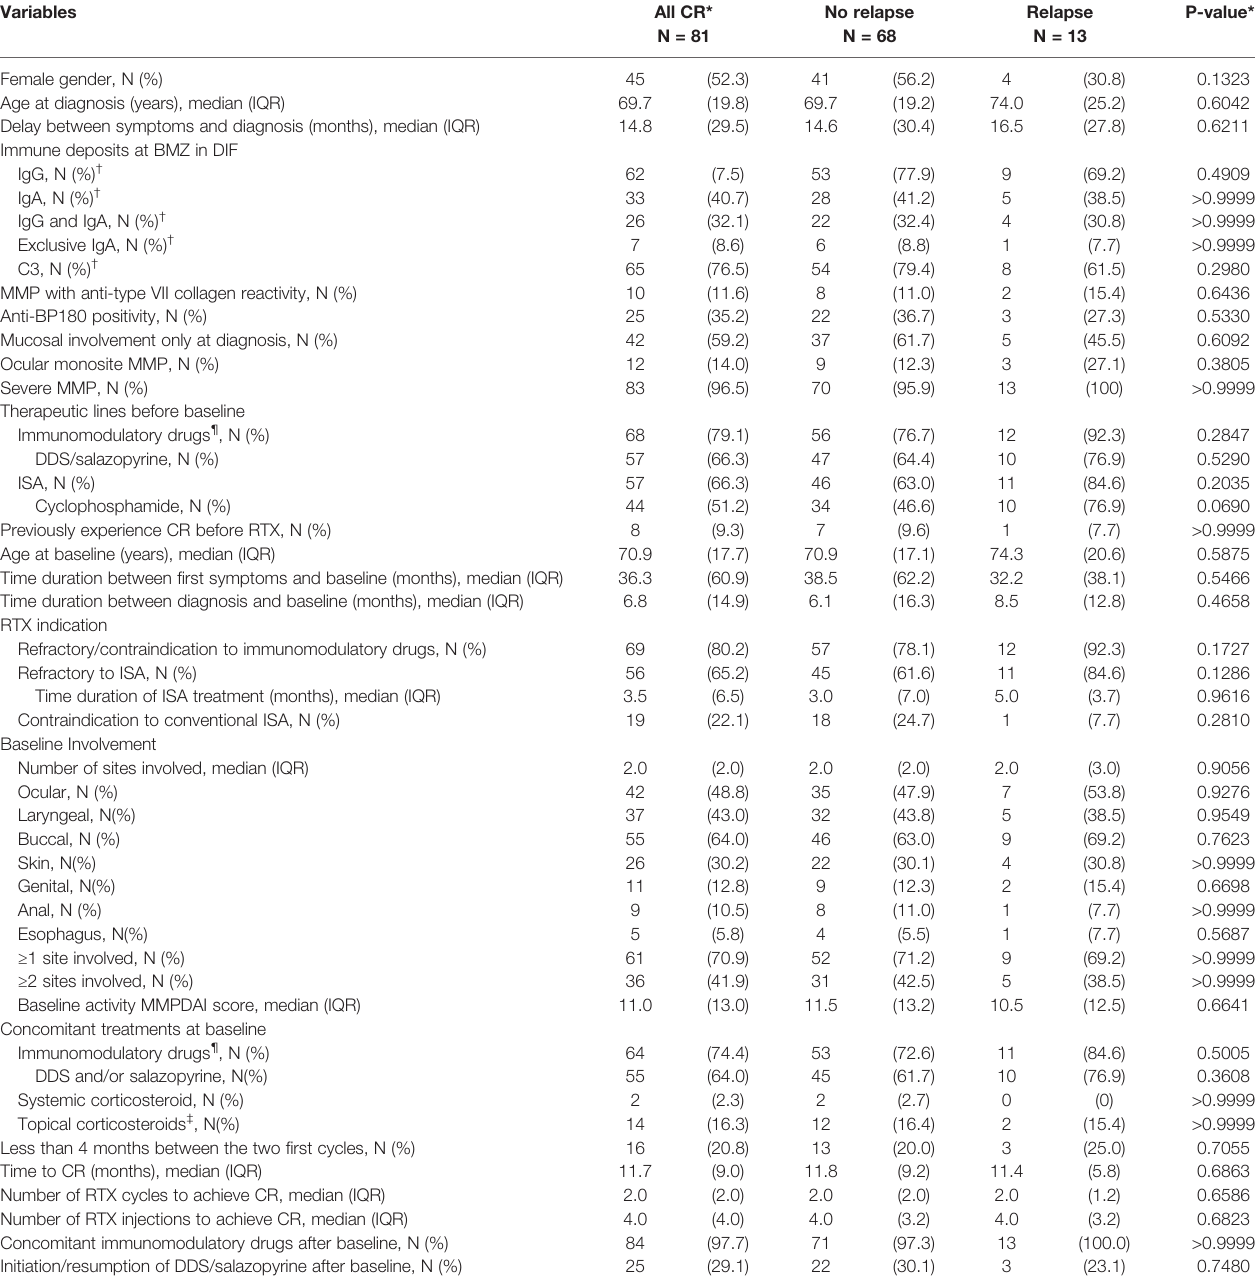
TABLE 6 | Univariate analysis: factors associated with relapse within 6 months after complete response in 86 patients with MMP.